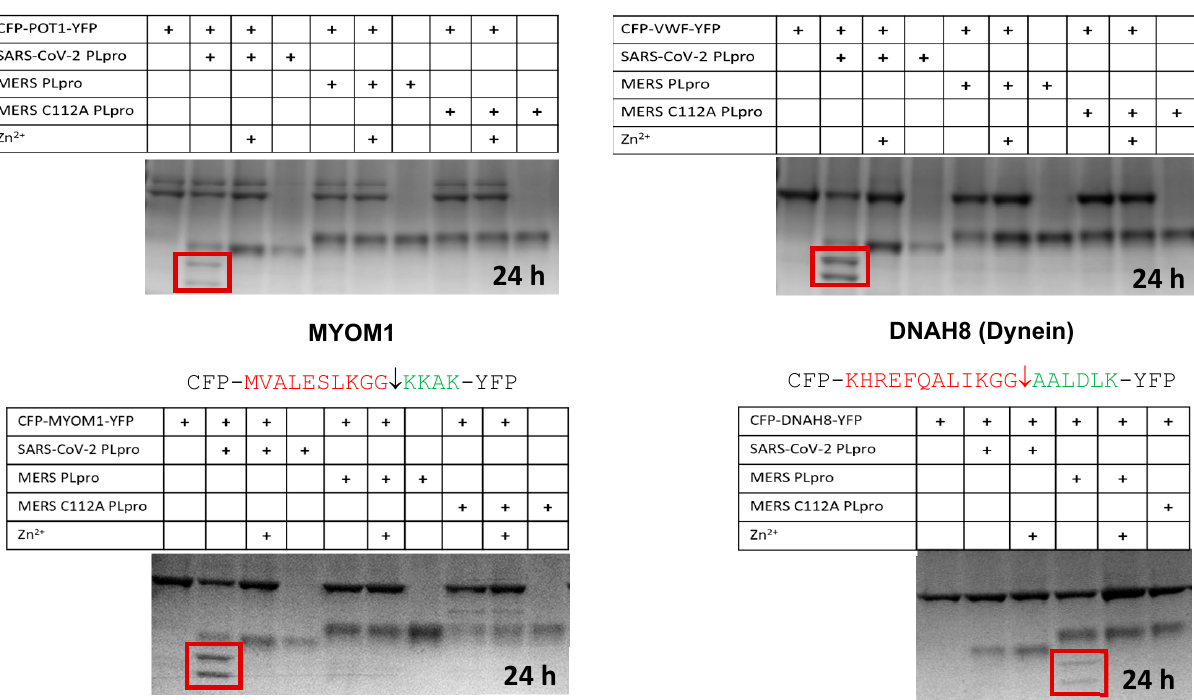
Figure 5. In vitro cleavage assays using cyan and yellow fluorescent protein substrates for POT1, VWF, MYOM1, and DHAH8 with the SARS-CoV-2 PLpro or the MERS PLpro. Cleavage products are boxed in red. Zinc inhibits the PLpro. The MERS C112A PLpro was used as a control.